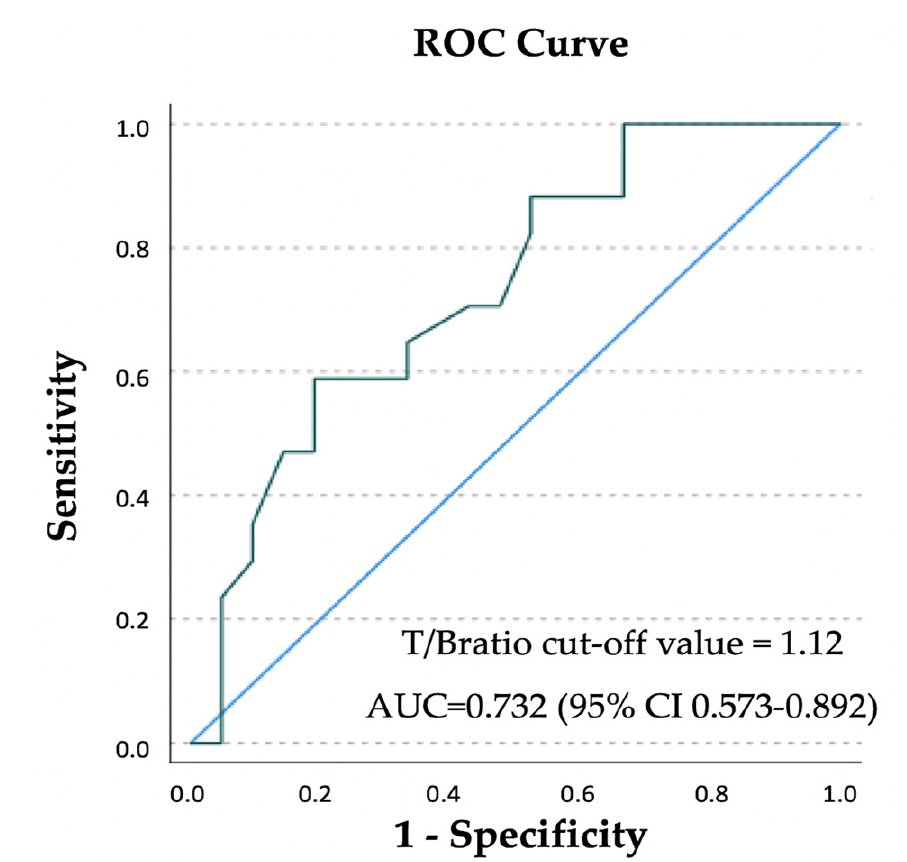
Figure 6. [ 18 F]Fluciclovine PET/CT performance in relation to T/Bratio. ROC analysis identified the optimal cut-off value of 1.12 with an AUC of 0.732.